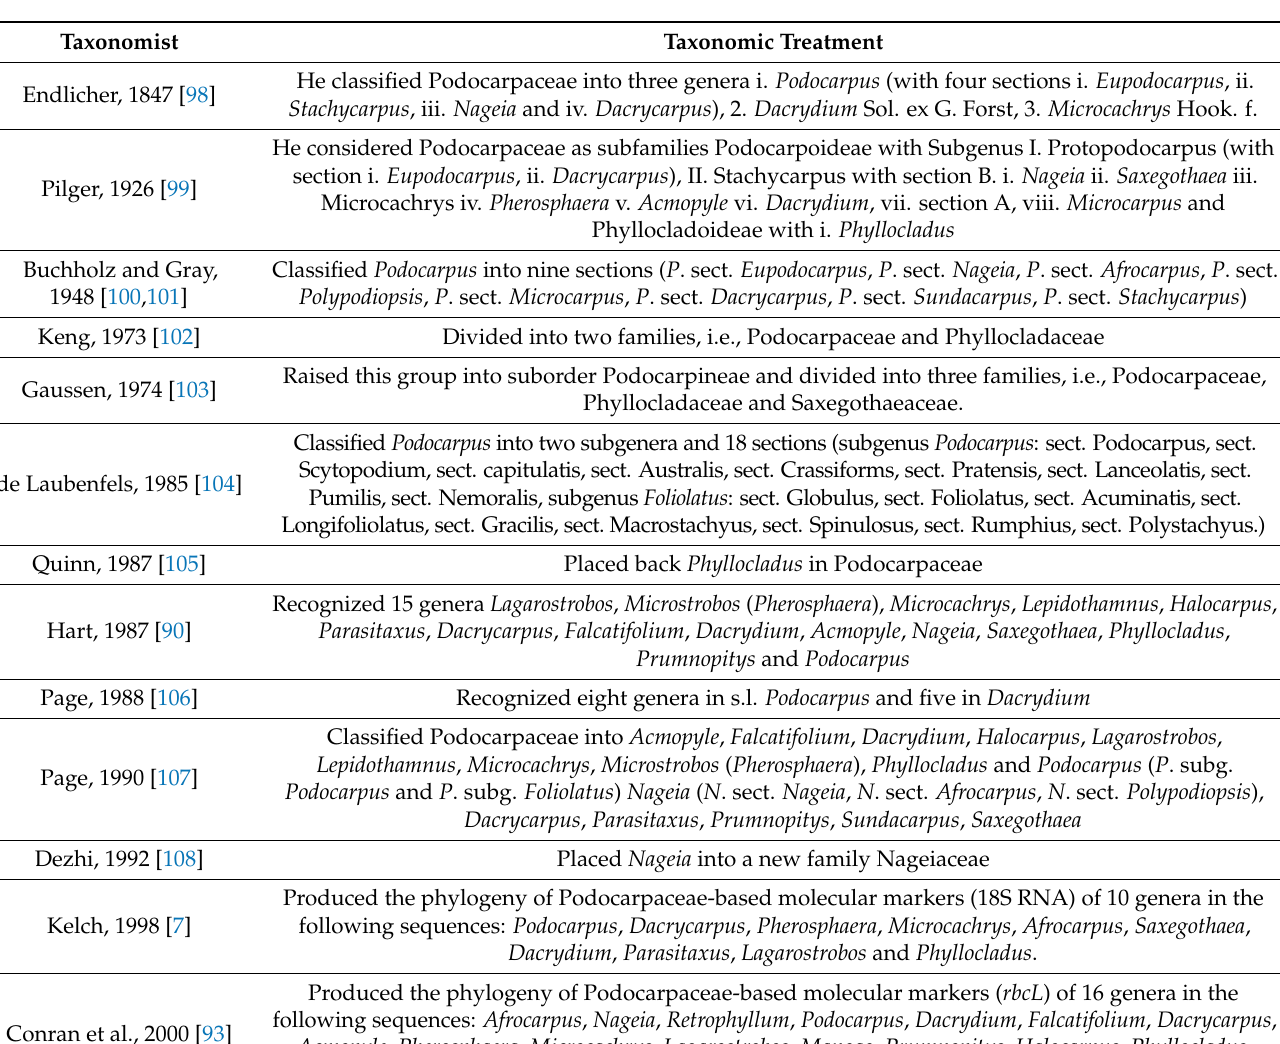
Table 3. A brief historical overview of major taxonomic classifications of Podocarpaceae (Type genus Podocarpus elongatus